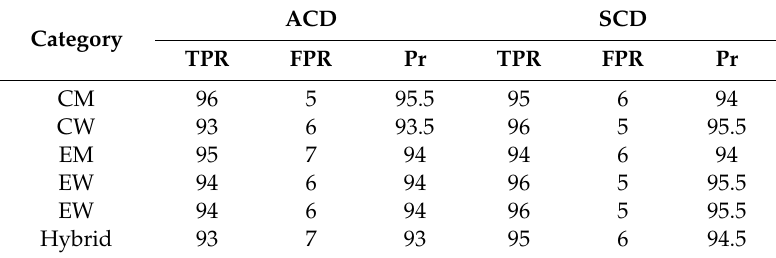
Table 3. Average values of a first-class detection (ACD) and second-class detection (SCD) results (%). ACD Category